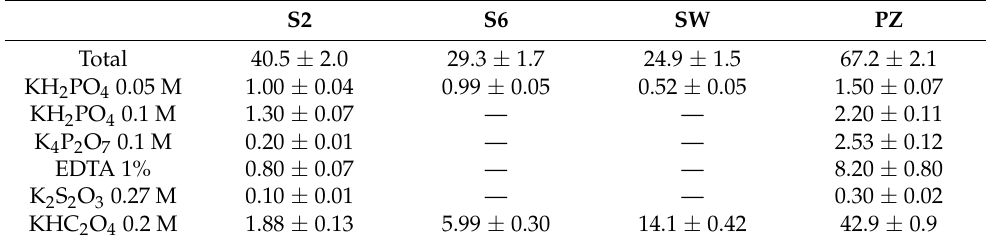
Table 2. Arsenic content (mg kg − 1 ) in the individual samples collected at the site under investigation. Values are reported as mean ( n = 3) ±